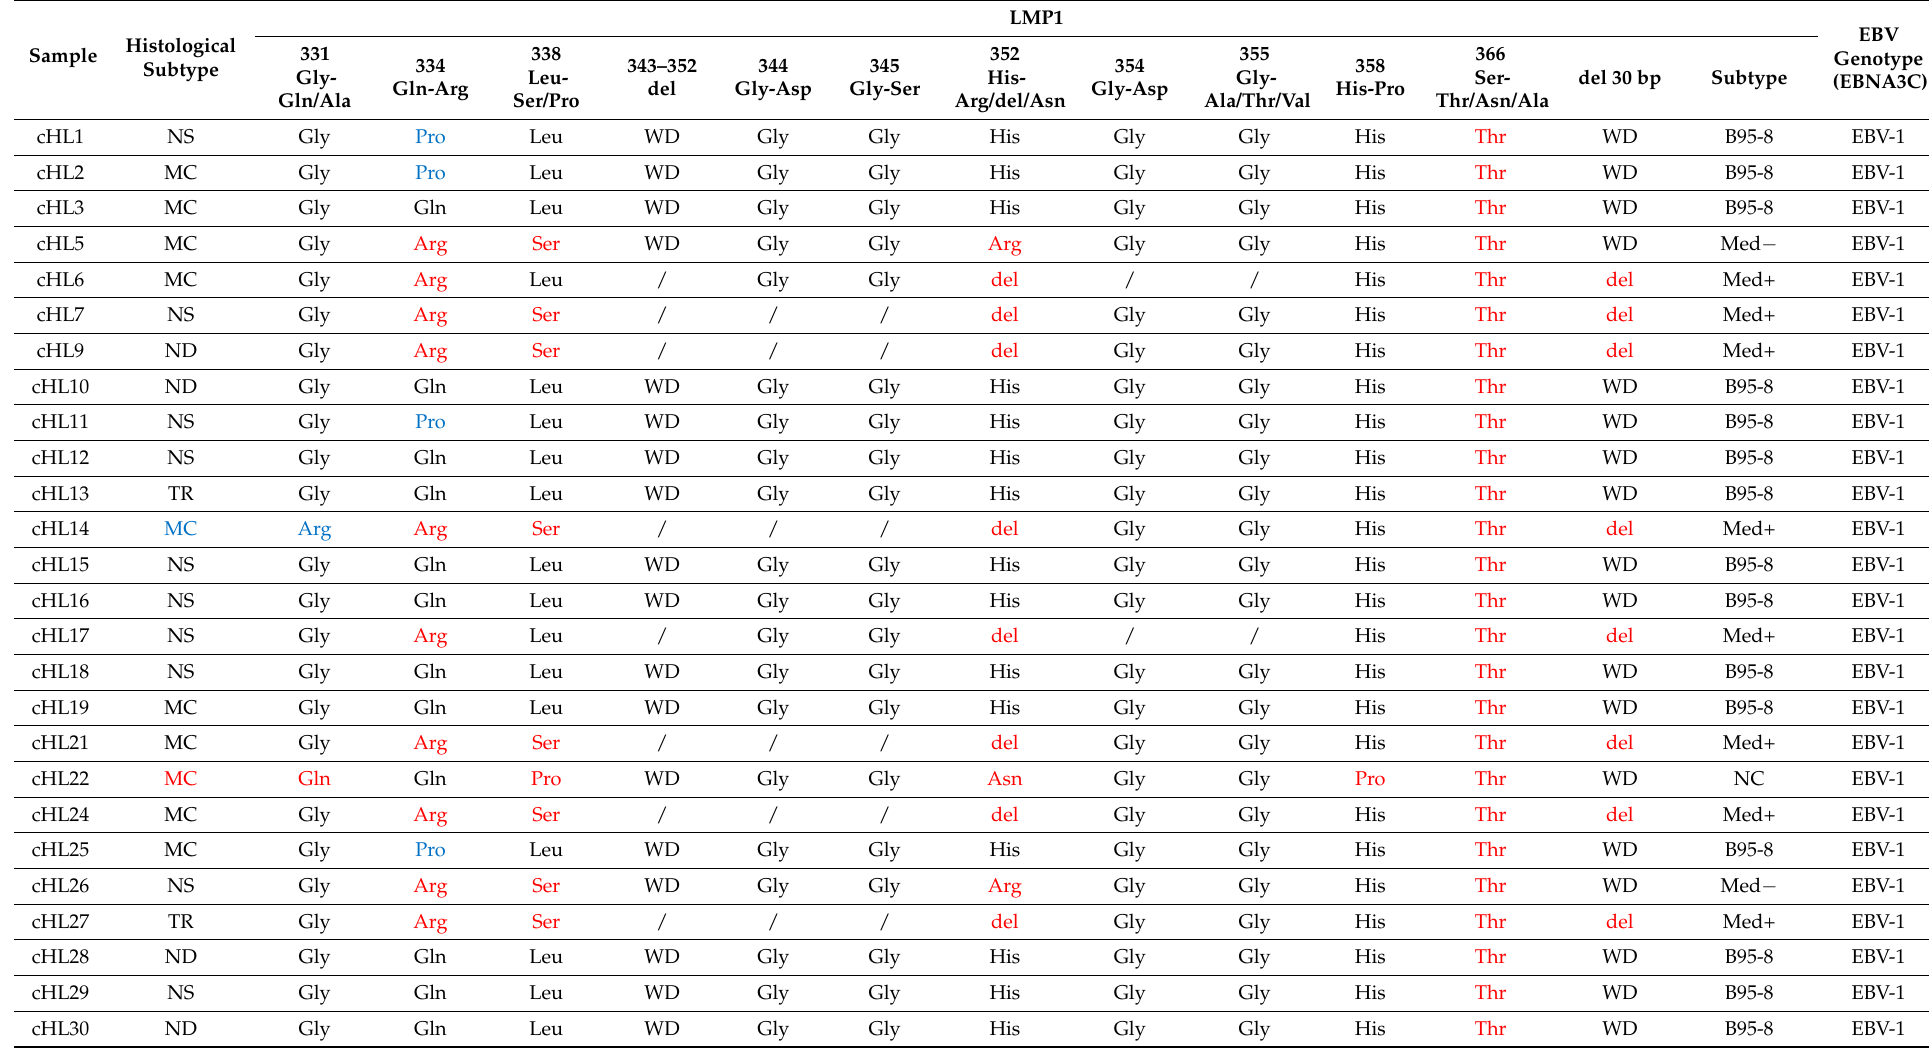
Table 2. EBV subtypes determined by LMP1